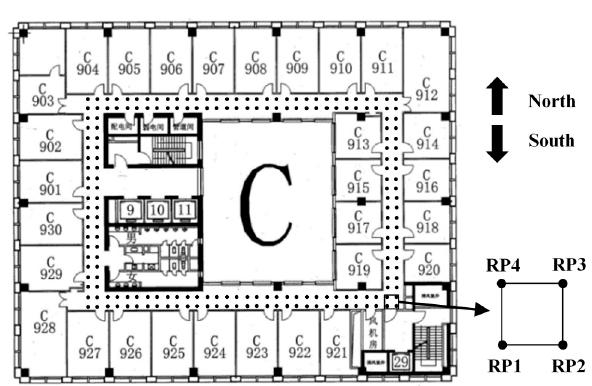
Figure 9. Floor layout.